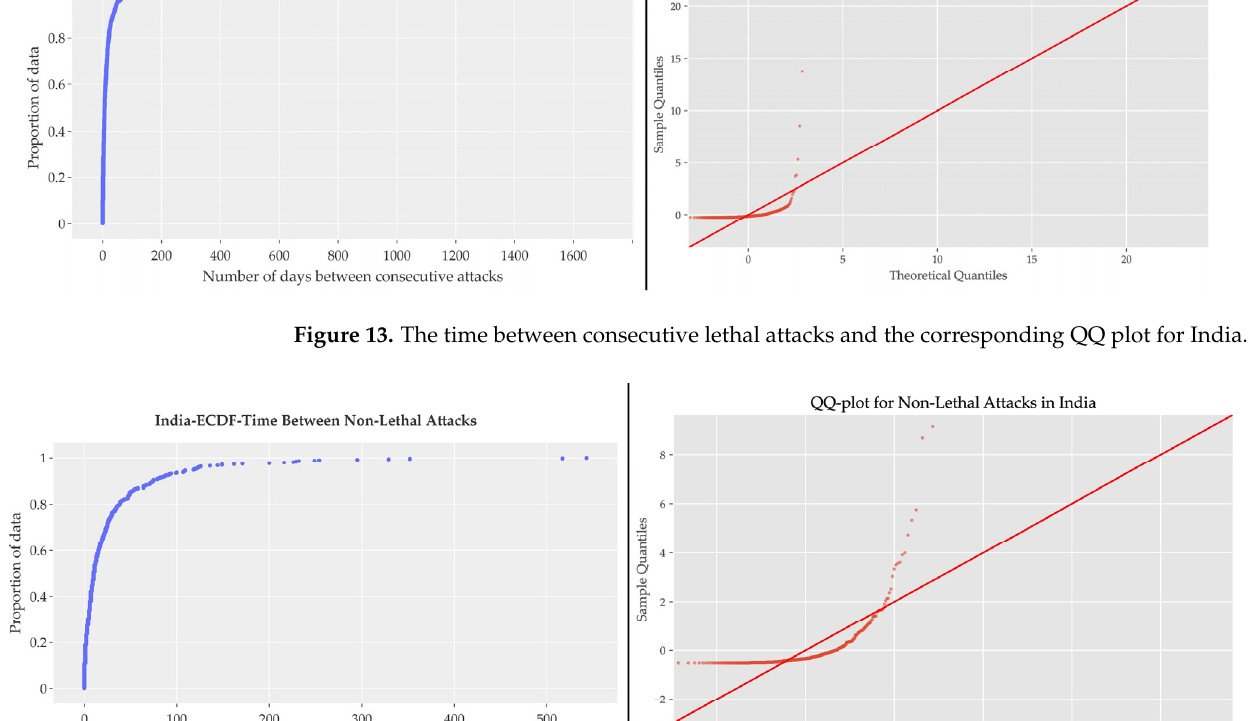
ISPRS Int. J. Geo-Inf. 2023 , 12 , x FOR PEER REVIEW